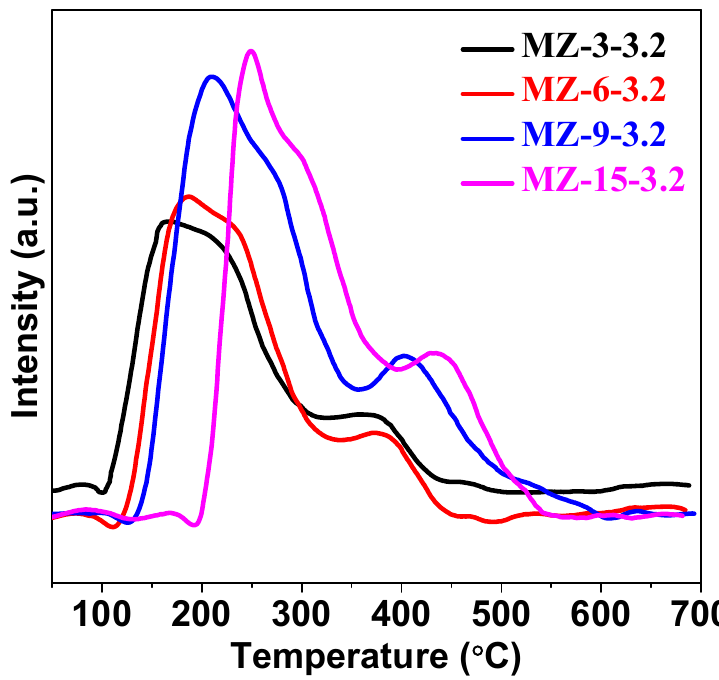
Figure 5. NH 3 -TPD profiles of MZ-3-3.2, MZ-6-3.2, MZ-9-3.2, and MZ-15-3.2. Figure 5. NH 3 ‐ TPD profiles of MZ ‐ 3 ‐ 3.2, MZ ‐ 6 ‐ 3.2, MZ ‐ 9 ‐ 3.2, and MZ ‐ 15 ‐ 3.2.